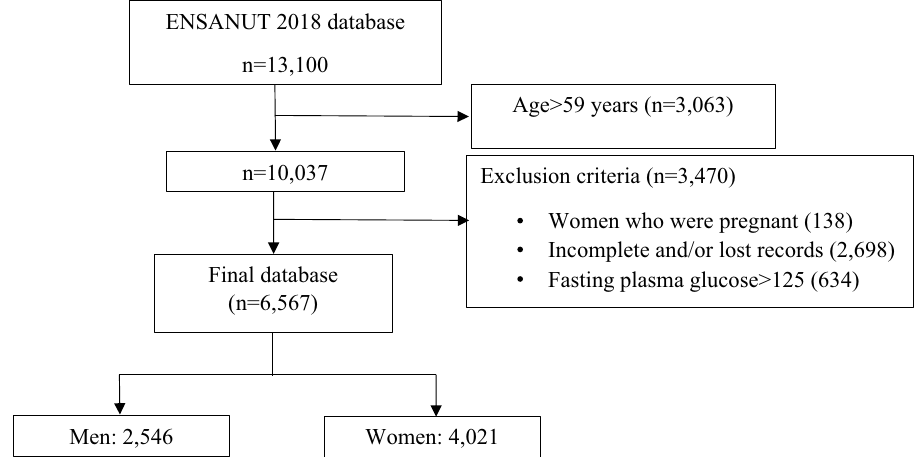
Figure 1. Flow diagram for obtaining the database for the formulation of the